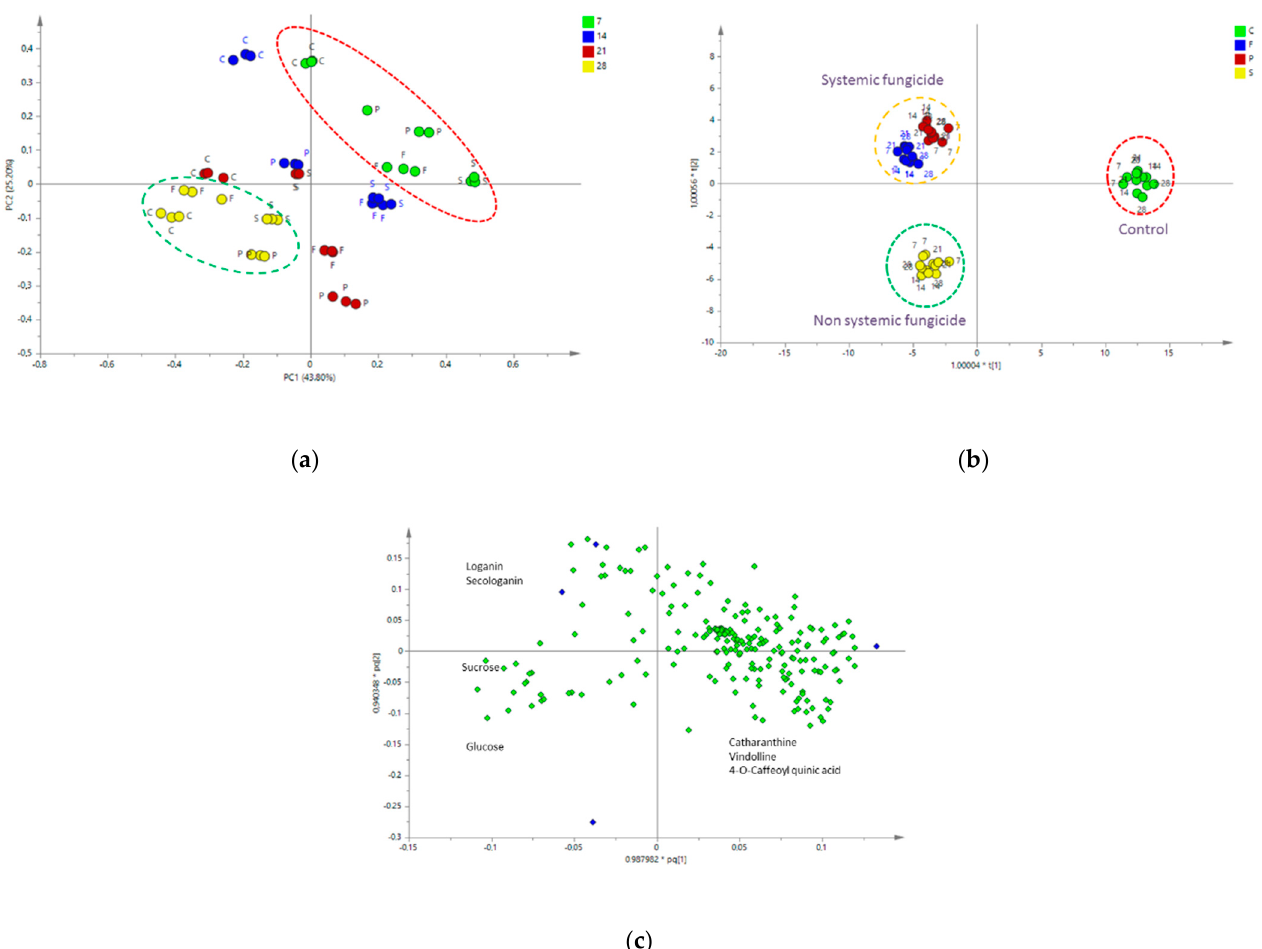
Figure 5. ( a ) Score scatter plot showing result of the PCA with all of the seedling samples. The numbers correspond to harvesting time (7, 14, 21, and 28 days after treatment) and the letters to fungicides (P—Pronto Plus, F—Folicur, and S—Switch) and control—C. ( b ) Score scatter plot showing result of the OPLS-DA with all of the seedling samples. ( c ) OPLS-DA loading scatter plot.